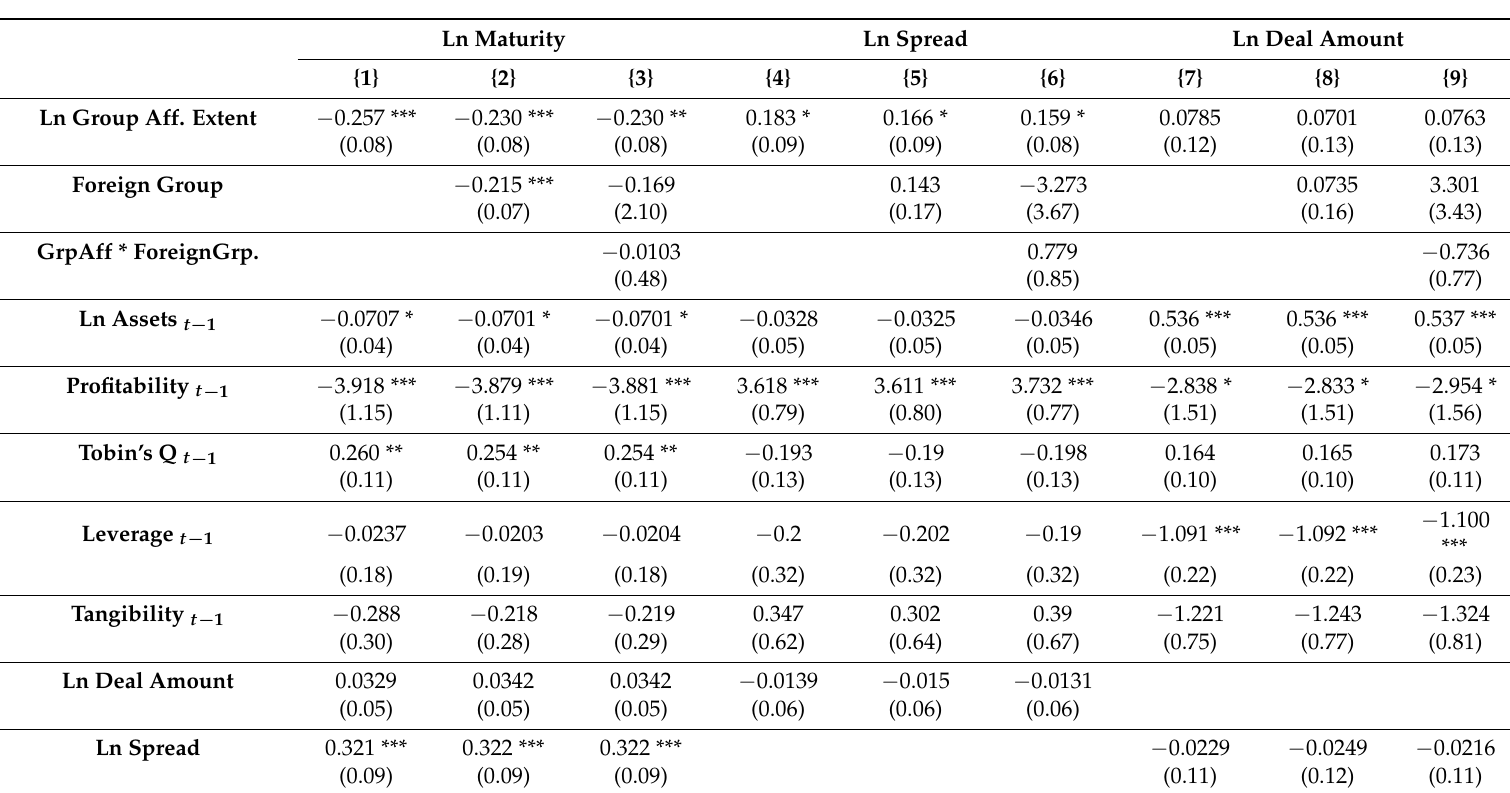
Table 9. OLS regressions of Cost of Loans on Group Affiliation Extent, Foreign Group, and Borrower and Loan Characteristics. Table 9 presents the pooled ordinary least squares (OLS) regression results of ln (Maturity), ln (Spread), and ln (DealAmount) on Group Affiliation Extent, Foreign Group, interaction terms, and Borrower and Loan Characteristics. Group Affiliation Extent is calculated based on the percentage of group ownership in borrower firms (0% indicates that there is no group association, and 100% means that the associated group owns all the firm’s shares). Control variables include firm and loan characteristics, and loan type, year, and industry dummies. Robust standard errors are reported in parentheses. Each model is clustered at group level to control for possible group fixed effects. *, **, and *** represent significance levels of 10%, 5%, and 1%